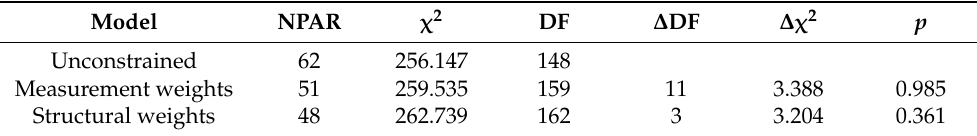
Table 9. Comparison regressing coefficients between